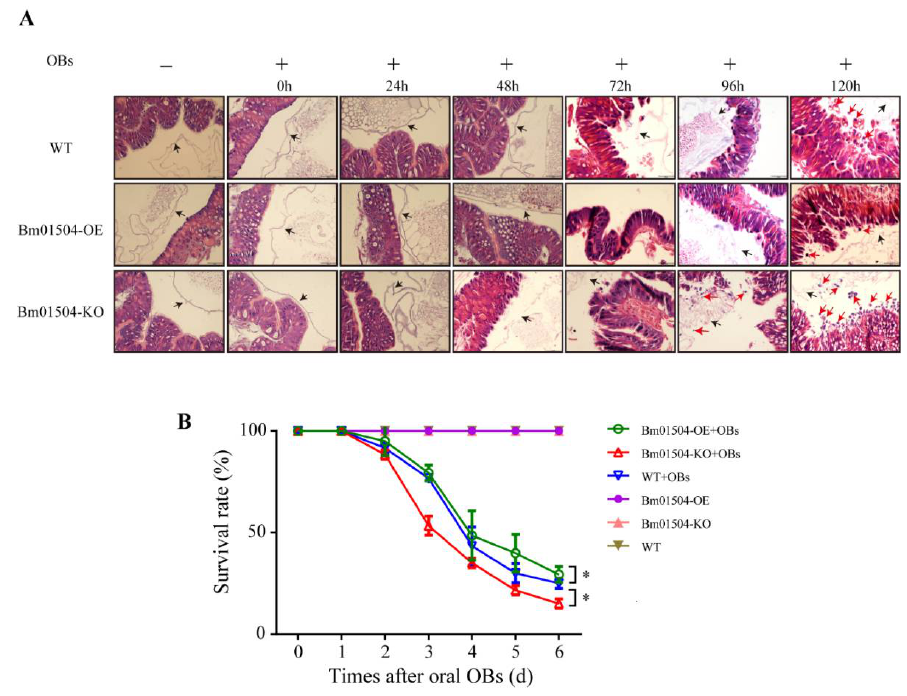
Figure 6. Economic characteristics of Bm01504-KO, Bm01504-OE, and WT. ( A ) Weight changes in the transgenic lines and WT from the third instar to 6th day of the fifth instar. The average weight of 30 larvae per group is shown. 3l, Third instar of larval stage; 4l, Fourth instar of larval stage; 5l, Fifth instar of larval stage; nd, Day n; ( B ) analysis of the cocoon shell rate of the transgenic lines and WT at pupal stage. Thirty cocoons of each silkworm strain were randomly selected on 3rd day in the pupal stage, and the cocoon shell rate was calculated. Each value represents the average of three repeated measurements. The experiments were repeated